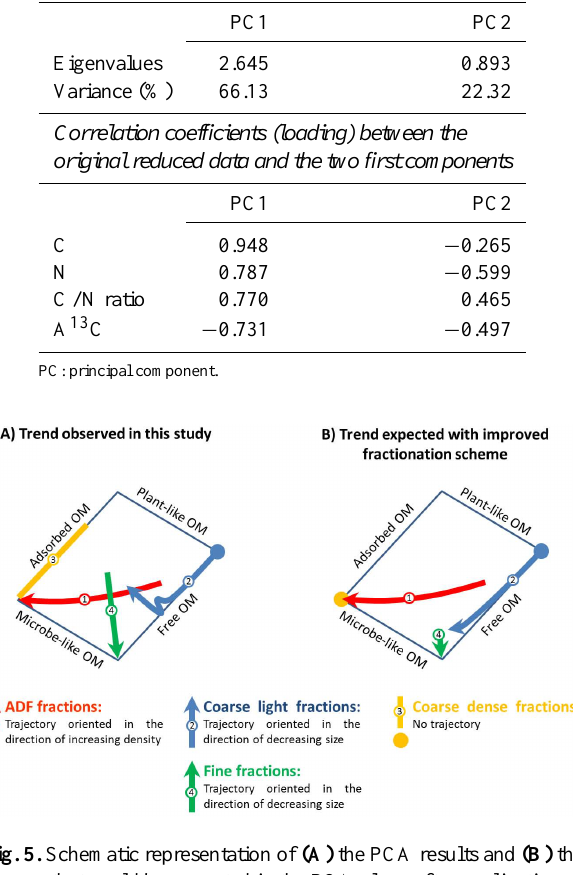
Fig. 5. Schematic representation of (A) the PCA results and (B) the change that could be expected in the PCA plane after application of the improved PSDF (Fig. 6) Fractionation procedure.